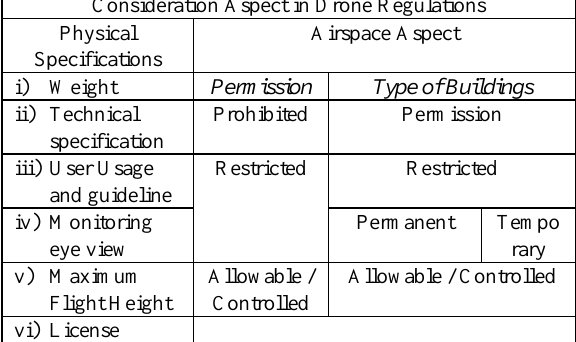
Table 3: General aspect of drone regulation has been considered from each country